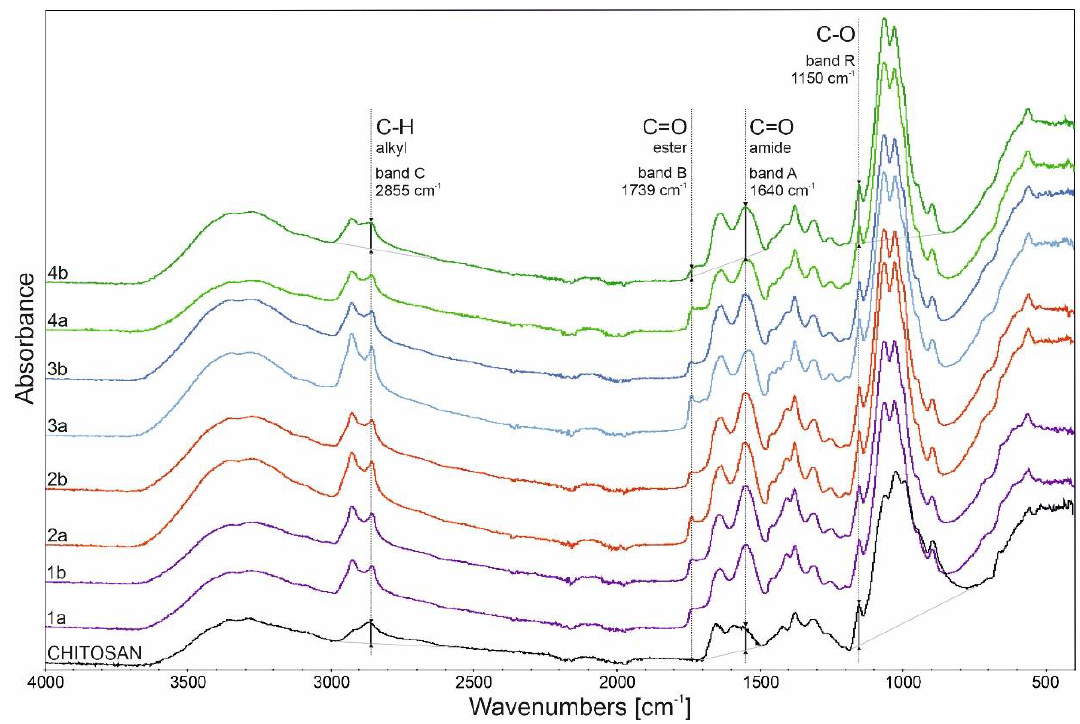
Figure 1. Infrared spectra of chitosan and chitosan derivatives.